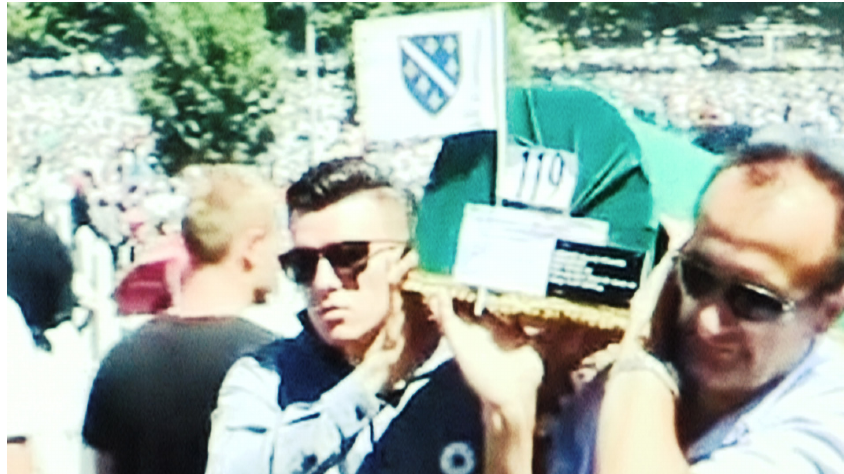
Fig. 4. Still from the documentary-poetry film Bridges <Bosnia 20>